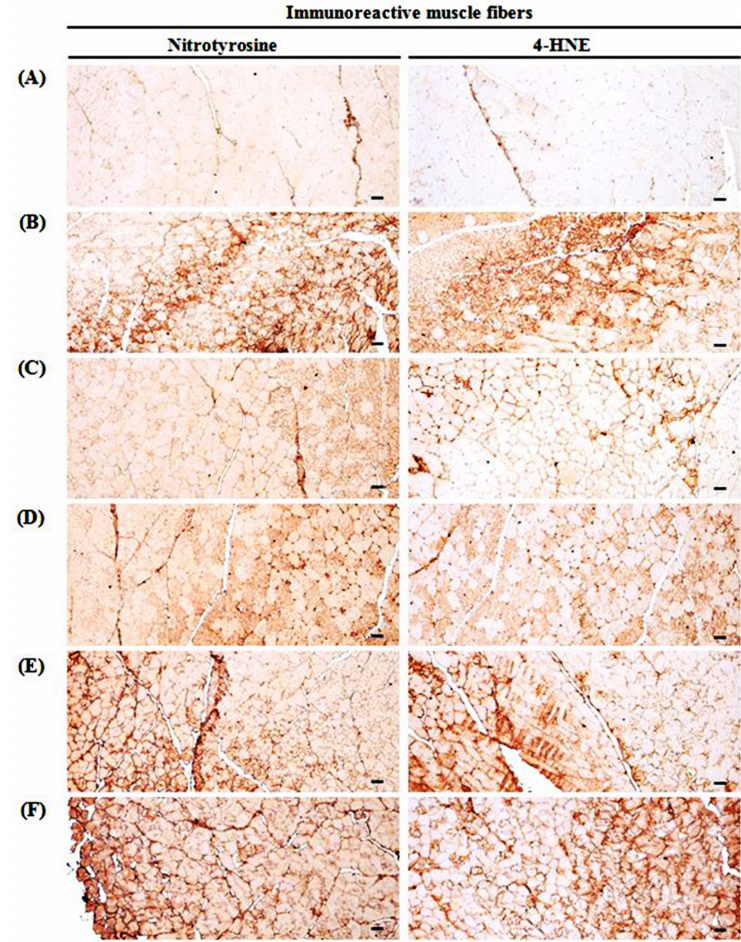
Figure 9. Selective gastrocnemius muscle nitrotyrosine and 4-HNE-immunoreactivities. ( A ) Intact vehicle control (distilled water administered and treated with saline). ( B ) GLU control (distilled water administered and treated with DEXA). ( C ) Oxymetholone (50 mg/kg oxymetholone administered and treated with DEXA as reference). ( D ) TCcp500 (500 mg/kg TCcp administered and treated with DEXA–higher dose treated mice). ( E ) TCcp250 (250 mg/kg TCcp administered and treated with DEXA–middle dose treated mice). ( F ) TCcp125 (125 mg/kg TCcp administered and treated with DEXA–low dose treated mice). TCcp = tart cherry (Fruit of Prunus cerasus L., Rosaceae) concentrated powder. GLU = glucocorticoid. DEXA = dexamethasone. 4-HNE = 4-hydroxynonenal. All avidin- biotin complex methods. Scale bars = 40 µ